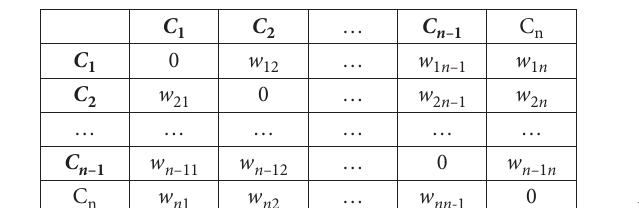
Fig. 6. Analysis of intensity degrees